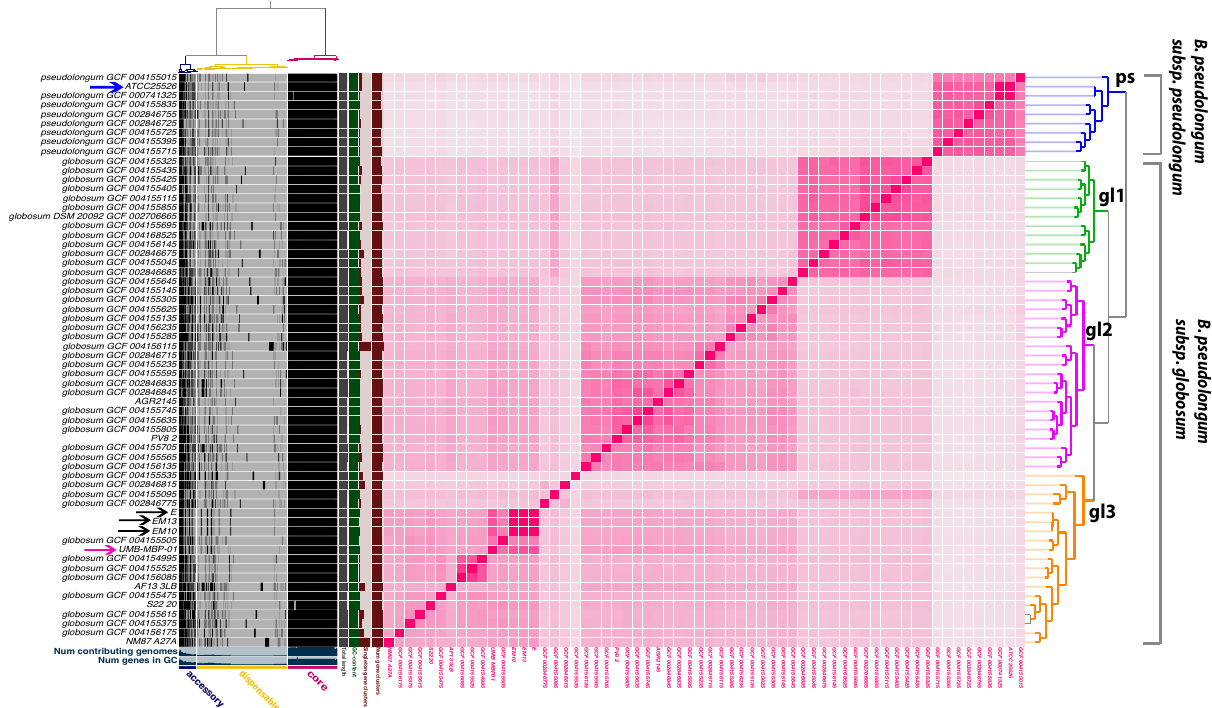
Figure 6. Pangenome analyses of B. pseudolongum genomes. Pangenome constructed using 79 strains, including the 5 strains sequenced in this study (Supplemental Table 3) and displayed using anvi’o vers 6.2 74 . Homologous gene clusters (HGCs) were identified based on all-versus-all sequence similarity in left panel and categorized as core, accessory or dispensable depending on their level of conservation. Genome ANI (Average Nucleotide Identity) was calculated using Sourmash vers 3.3 76 . Blue arrows indicate the two strains compared: ATCC25526 and UMB-MBP-001. Black arrows indicate the other three B. pseudolongum strains isolated from the source stool of pregnant